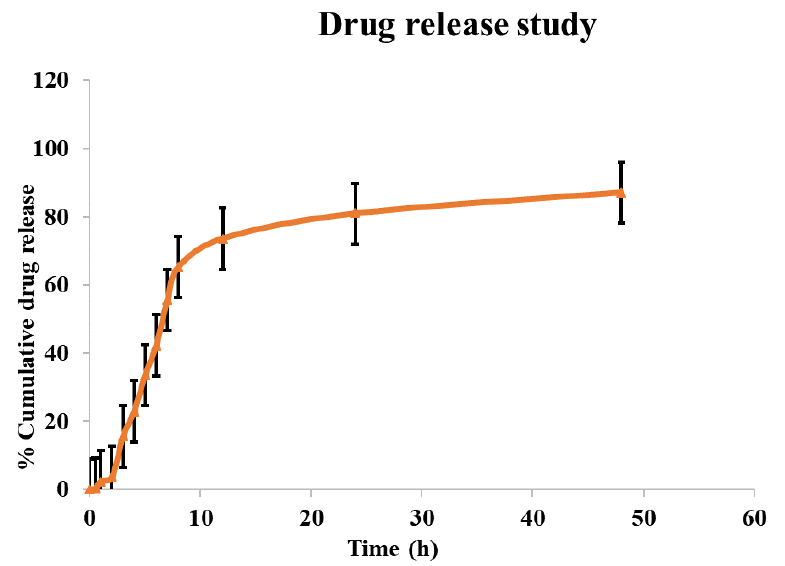
Figure 4. In vitro cumulative percentage drug release study of cisplatin-loaded SLNs for 48